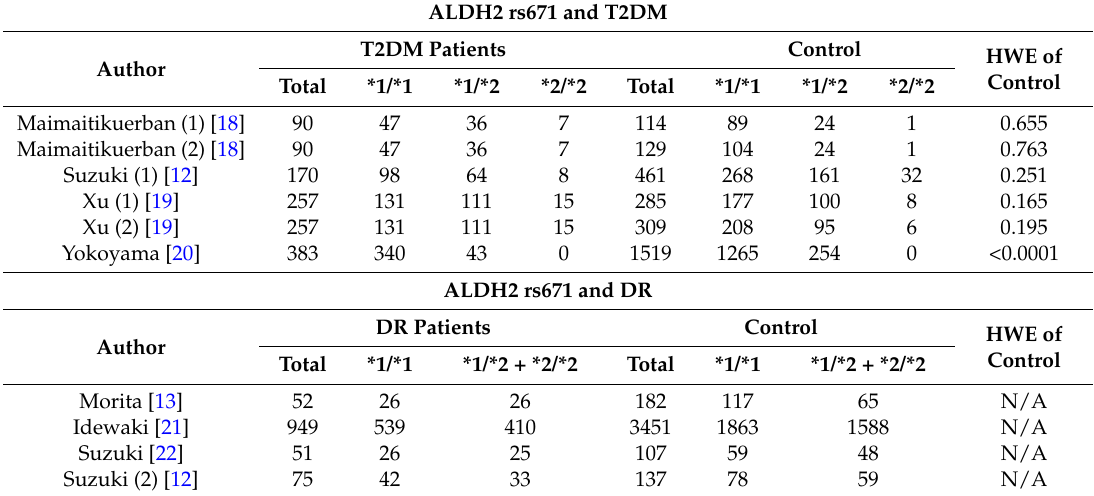
Table 2. Genotype frequencies of the ALDH2 rs671 polymorphism between case group and control group. ALDH2 rs671 and T2DM